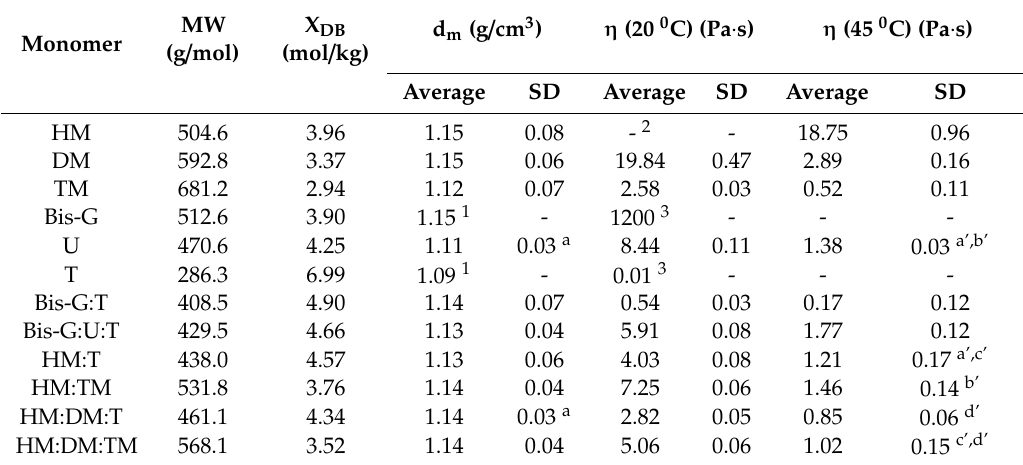
Table 2. the concentration of double bonds (X DB ), density (d m ) and viscosity ( η ) – measured at 20 ◦ C and 45 ◦ C. All density results were statistically insignificant ( p > 0.05), except for one couple which